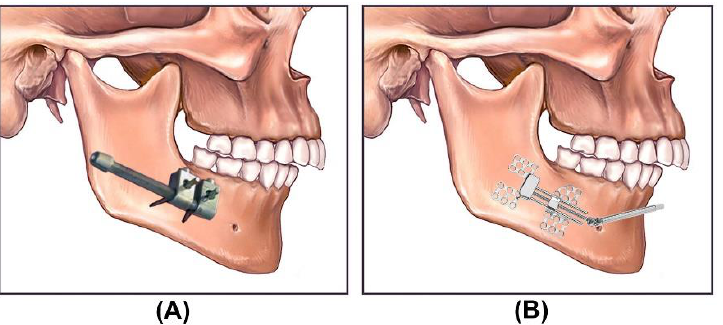
Figure 2. Illustration of the application of manual distractors in MRAs: ( A ) extra-oral distractor; ( B ) intra-oral distractor. ( B ) intra-oral